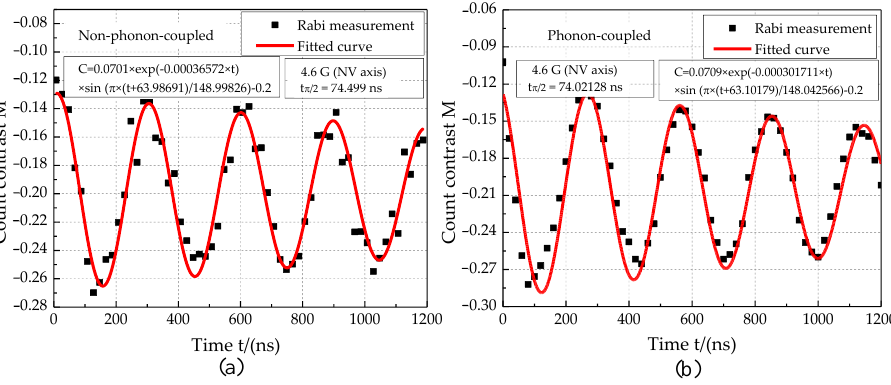
Figure 25. Rabi measurement results. ( a ) Non-phonon-coupled case. ( b ) Phonon-coupled case.